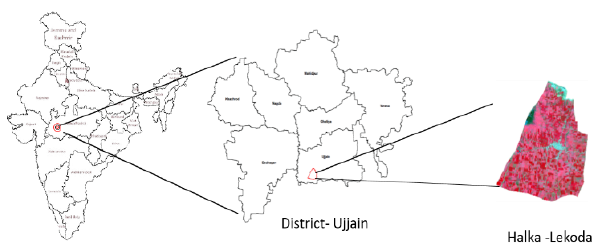
Figure 1. Study area selected in this study.